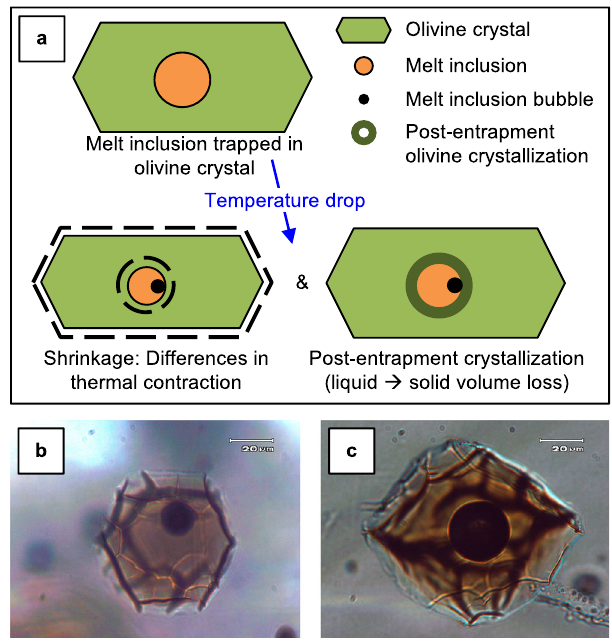
Fig. 1 MI bubble formation and representative Sunset Crater